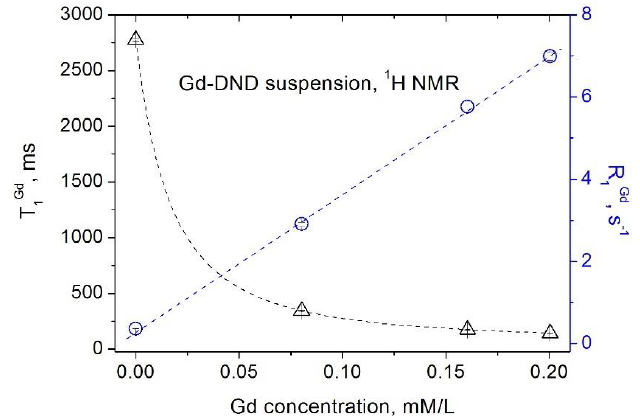
Figure 3. Dependence of the spin–lattice relaxation rate R 1 (circles) [16] and the spin–lattice relaxation time T 1 (triangles) of water protons in aqueous Gd-DND suspensions on the Gd 3+ ion concen- tration.